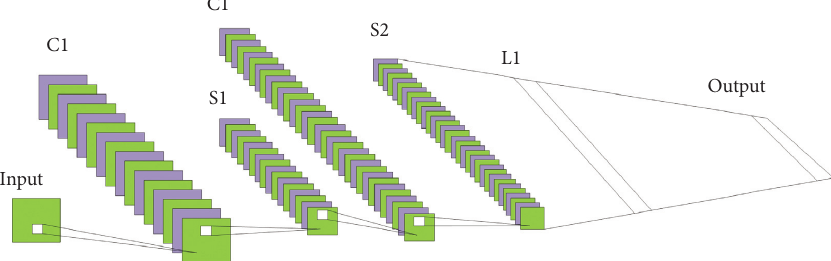
Figure 2: The structure of CNN2.